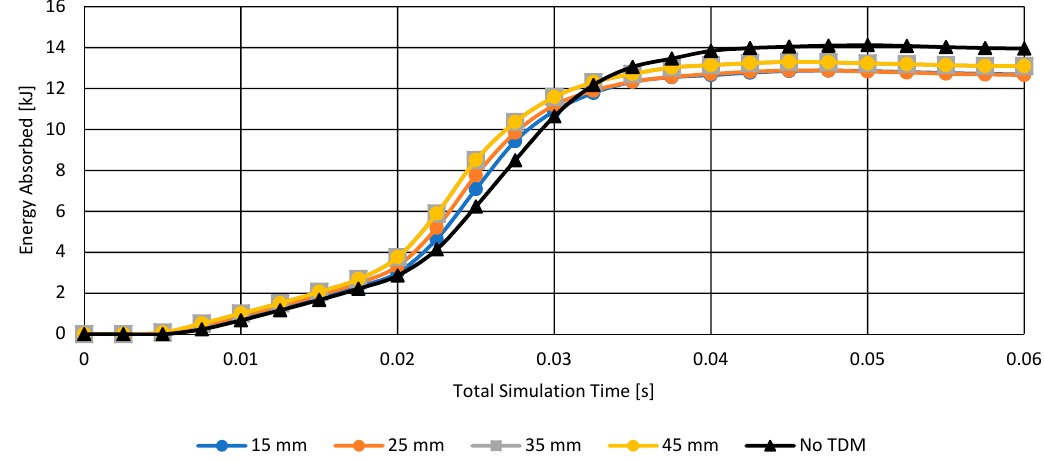
Figure 7. FEA results of energy absorptions of a vehicle after colliding on a street pole (frontal collision scenario) using five different thicknesses of TDM shielding.